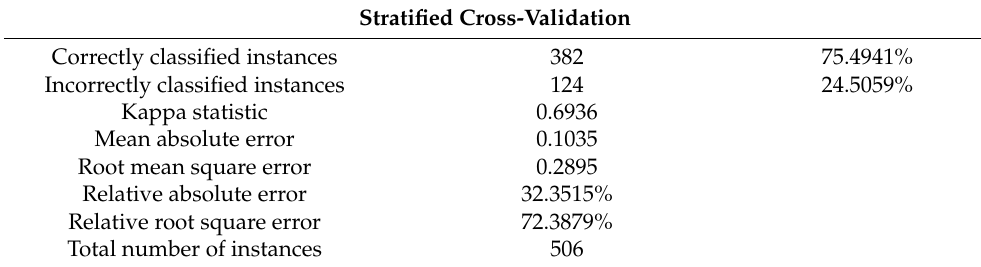
Table 14. Stratified cross-validation with a training dataset corresponding to 506 instances.